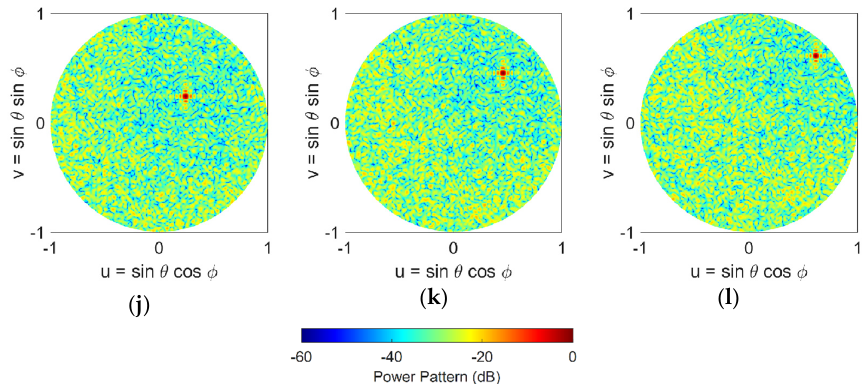
Figure 10. Normalized power patterns of the antenna arrays in the u-v space scanned along the elevation plane in φ = 45 ◦ direction with different element distributions: ( a ) uniform (20 ◦ scan), ( b ) uniform (40 ◦ scan), ( c ) uniform (60 ◦ scan), ( d ) random (20 ◦ scan), ( e ) random (40 ◦ scan), ( f ) random (60 ◦ scan), ( g ) Halton (20 ◦ scan), ( h ) Halton (40 ◦ scan), ( i ) Halton (60 ◦ scan), ( j ) Poisson disk (20 ◦ scan), ( k ) Poisson disk (40 ◦ scan), ( l ) Poisson disk (60 ◦ scan). The Halton sampling uses prime bases of 2 and